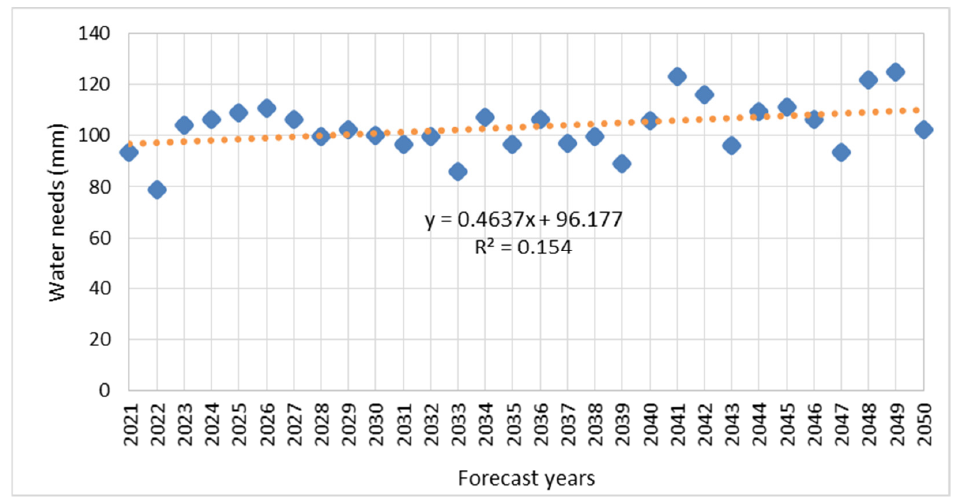
Figure 1. Predicted amounts of the giant miscanthus water needs in August, statistically significant,